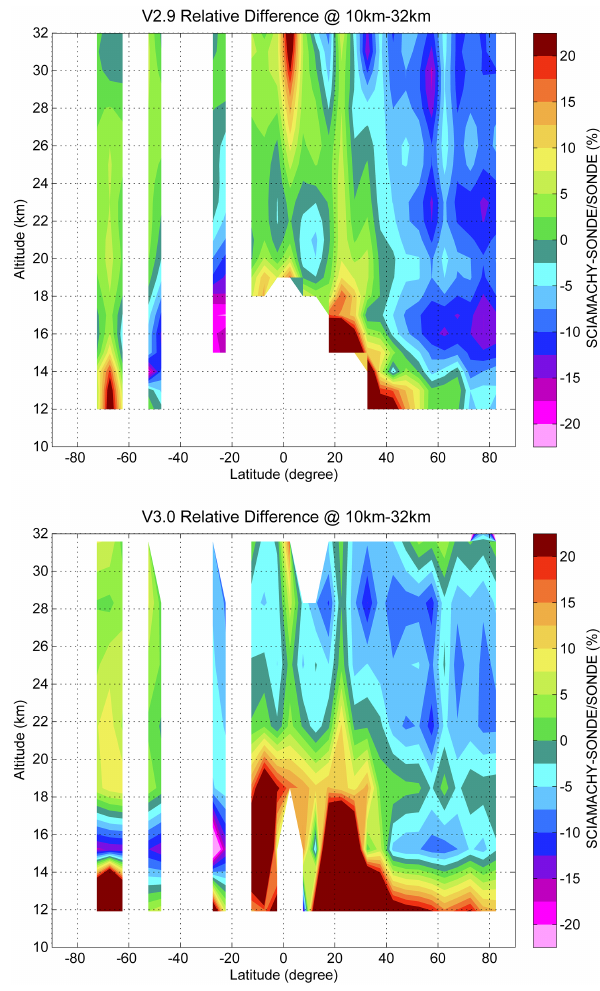
Figure 3. The altitude-versus-latitude cross section of the relative differences. V2.9 in the upper panel and V3.0 in the lower panel. The improvement is mainly in the NH high